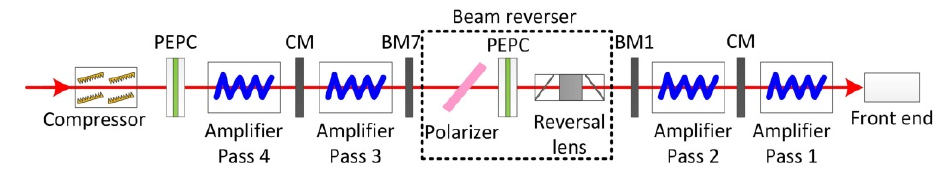
Figure 2. The optical path of retro-reflected pulses traveling